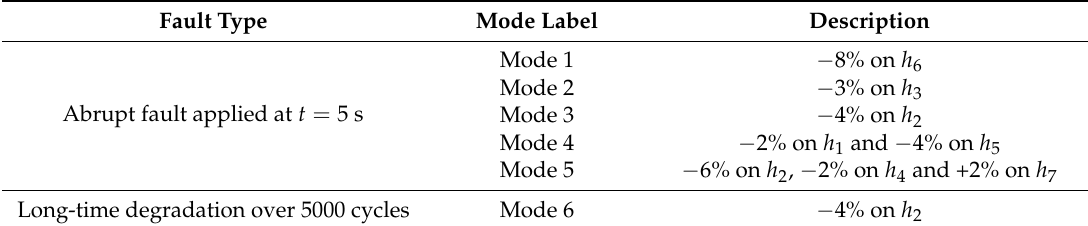
Table 1. The description of the considered